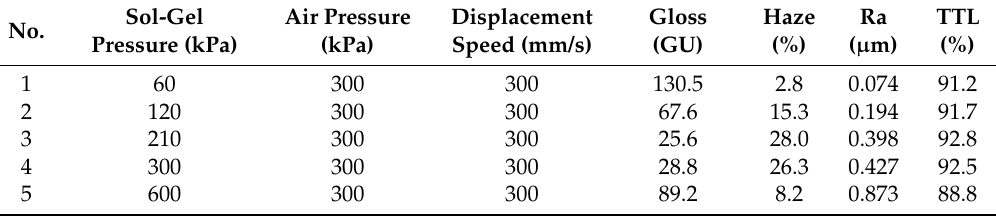
Table 1. Effects of the sol-gel deliver pressure on the gloss, haze, Ra, and TTL of the anti-glare thin films with air transport pressure and displacement speed of 300 kPa and 300 mm/s,